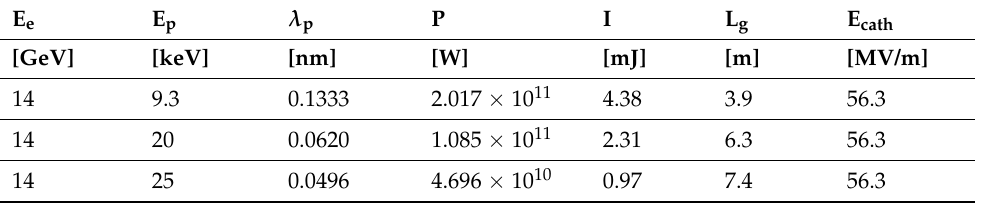
Table 1. Summary of SASE performance in the sub-ångström regime using low-emittance beams produced with about 56.3 MV/m cathode accelerating gradient at an electron beam energy of 14 GeV. An undulator period of 4 cm is used as that of the existing undulators at the European XFEL. The terms E e and E p denote electron beam energy and photon energy, respectively. The symbol λ p stands for the resonant wavelength of the photon beam. The notation P, I, L g and E cath represent saturation power level, photon intensity, gain length and the cathode accelerating gradient, respectively.